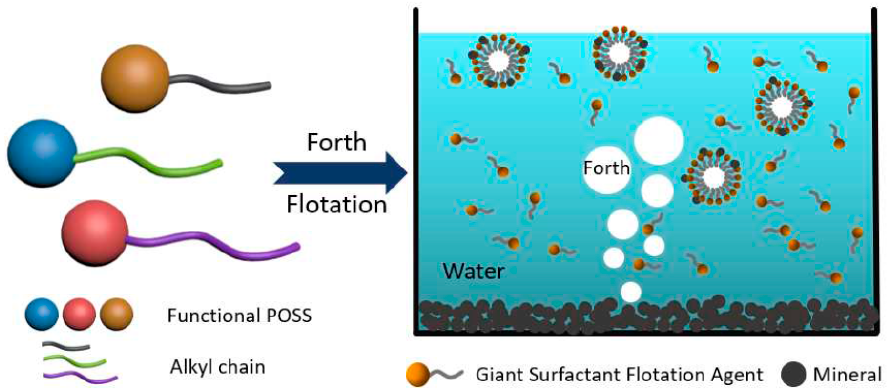
Figure 20. Forth Flotation Giant Surfactants. Reproduced with permission from Ref. [75]. Copyright (2019), with permission from